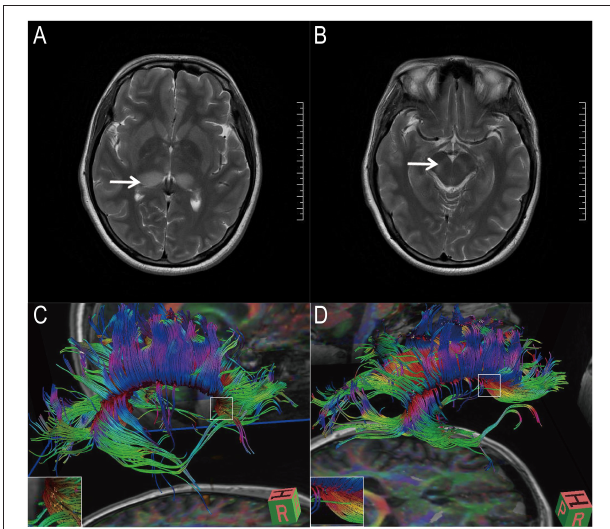
FIGURE 2 | Magnetic resonance image and diffusion tensor imaging image of 1 patient. (A,B) Magnetic resonance images showed that the patient’s thalamus (white arrow) and basal ganglia (white arrow) were lesions. (C,D) Diffusion tensor imaging showed that the patient’s corpus callosum tract was partially broken. Three months later, the patient’s corpus callosum rupture improved.